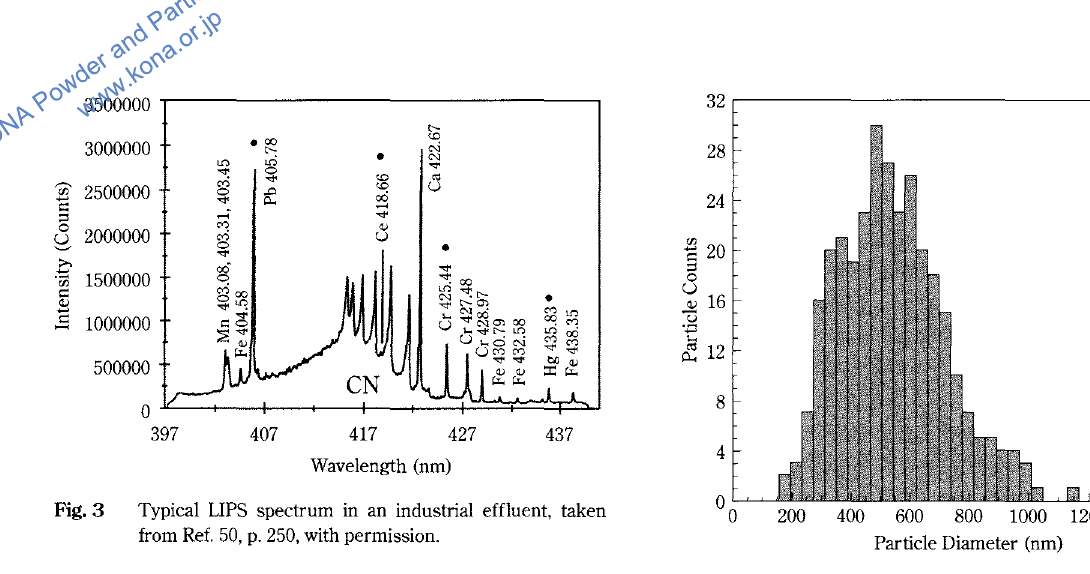
A LIPS-based sized distribution for chromium particles.